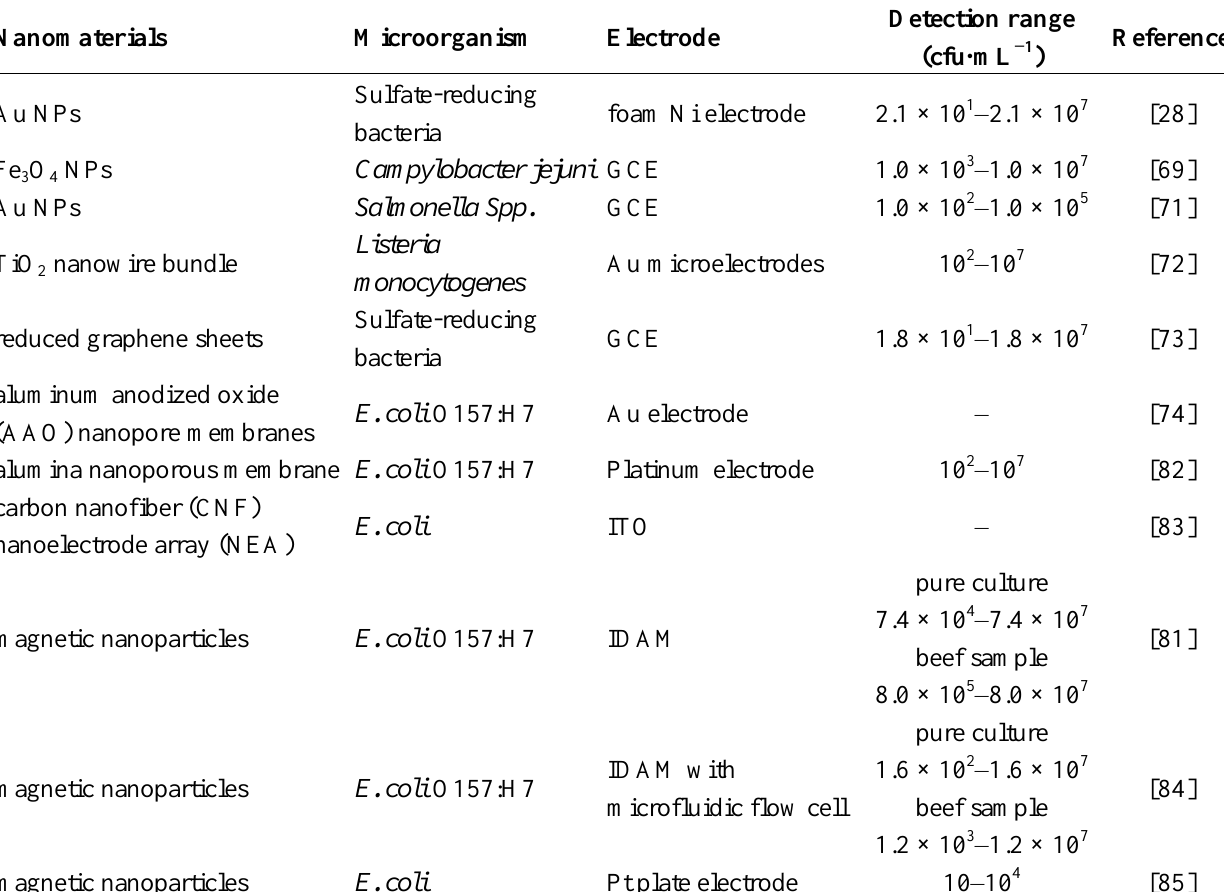
Table 1. Comprehensive list of nanomaterials based impedimetric biosensors for detection of foodborne pathogenic